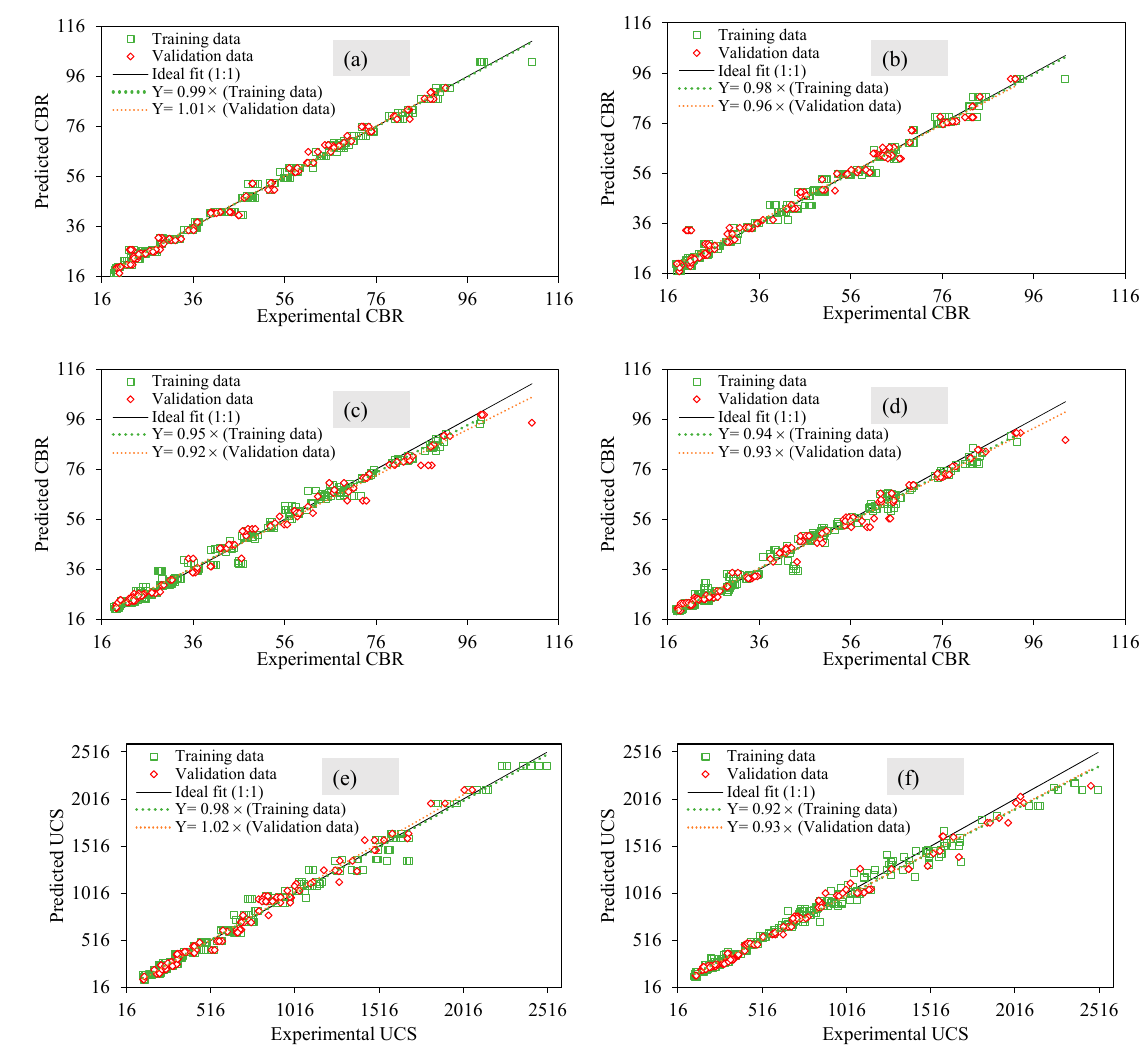
Figure 7. Statistical evaluation of: ( a , c , e ) ANN unsoaked CBR, soaked CBR and UCS, ( b , d , f ) RF Unsoaked CBR, soaked CBR and UCS, respectively. Table 4. Statistical evaluation of the developed ANN and RF